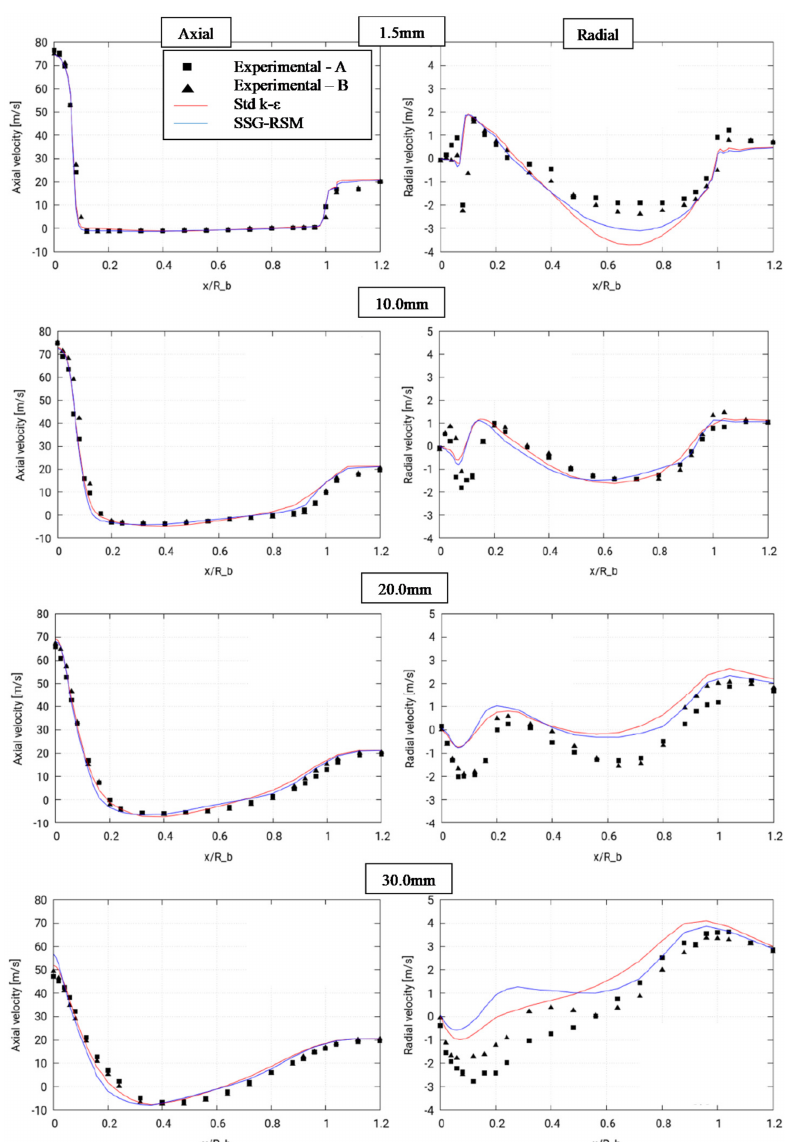
Figure 3. Axial and radial velocity profiles at increasing axial distances. Nonreactive flow simulations. Complete experimental data available at reference